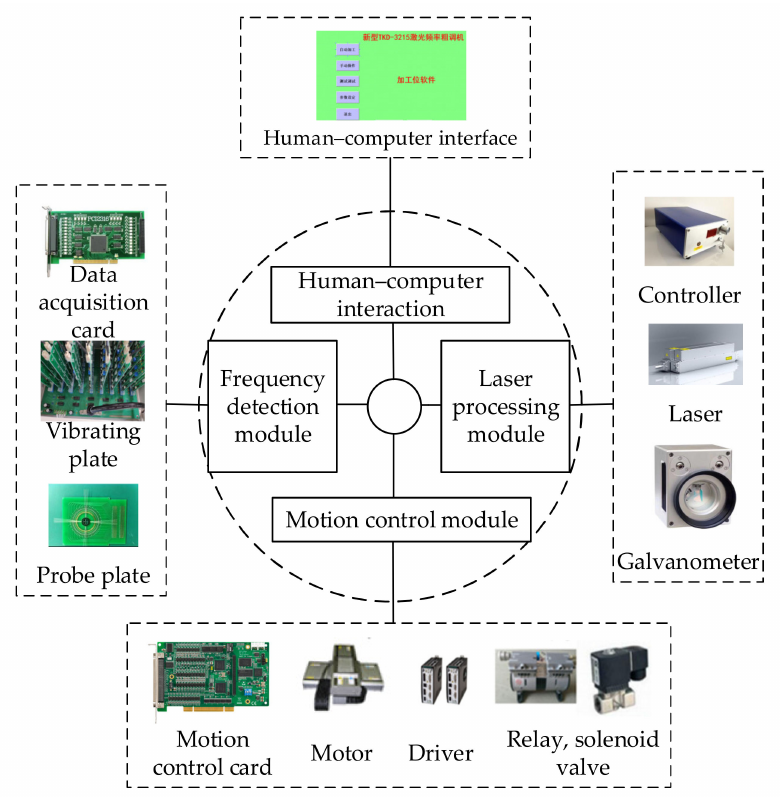
Figure 9. Structure diagram of laser processing control system for MCR frequency